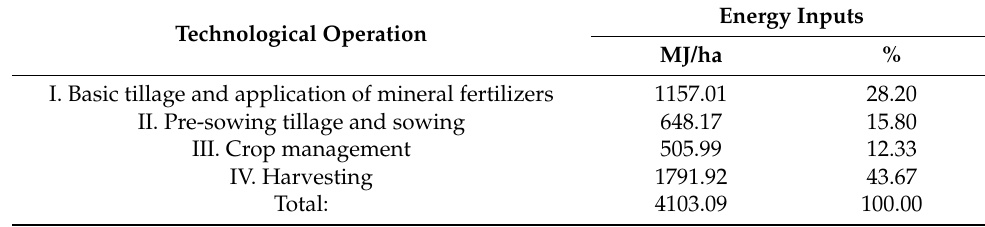
Table 10. Structure of energy consumption by technological operations (direct and investment